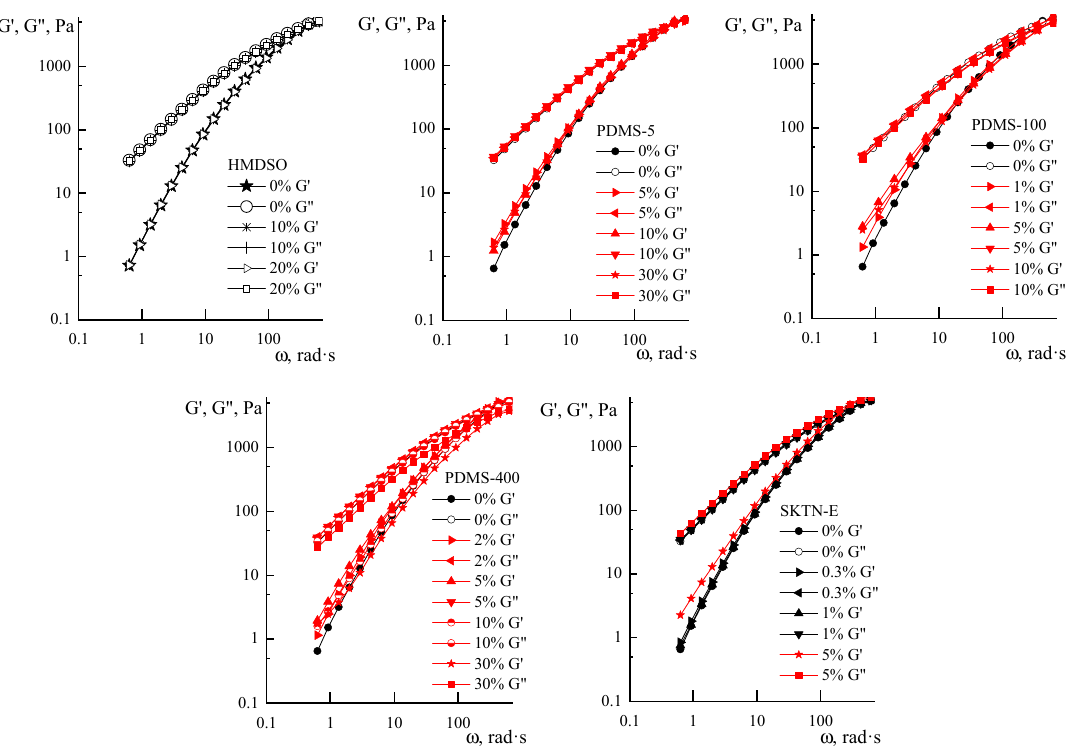
Figure 10. Frequency dependences of the elastic and loss moduli for PAN solutions containing PDMS.